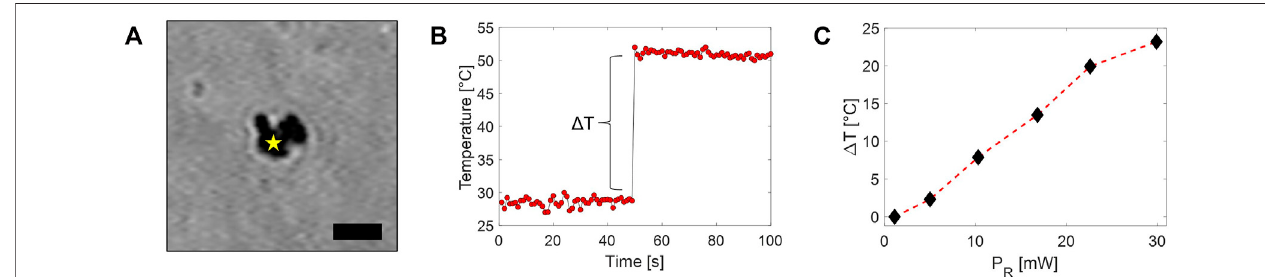
FIGURE 5 | (A) Bright- fi eld image of a 2D-MoS 2 agglomerate adhered to a glass coverslip (scale bar = 2 μ m). The star highlights the position of the Raman probe during the acquisition of the time series of Raman spectra, leading to temperature data shown in part B. (B) Temperature trend of the 2D-MoS 2 agglomerate obtained under irradiation ofthe Raman beam. The sharp temperature increase isobtained in correspondence of the P R stepwise increase. (C) Measured 2D-MoS 2 agglomerate temperatures rise observed under irradiation at different P R .